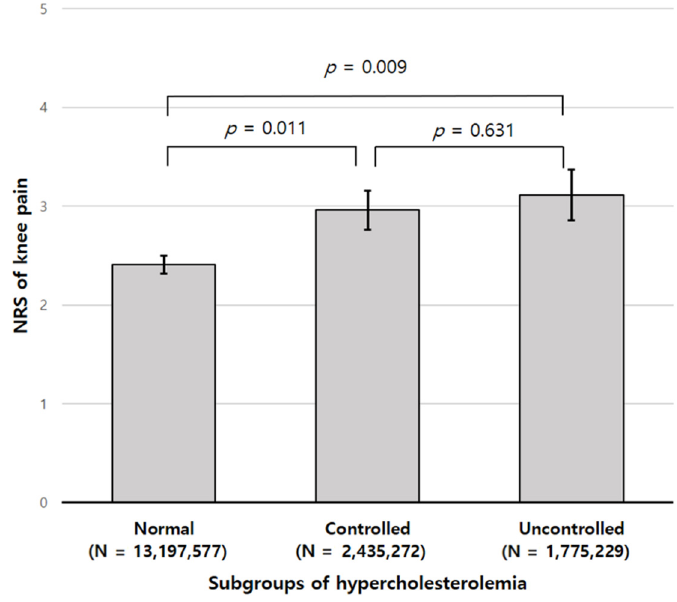
Figure 3. Comparison of mean numeric rating scale (NRS) of pain according to the subgroup of hypercholesterolemia. Values are presented as the mean ± standard error (SE).